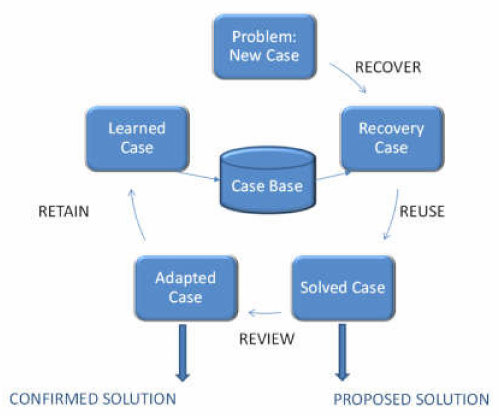
Figure 3. Standard cycle of the CBR method adapted by Watson